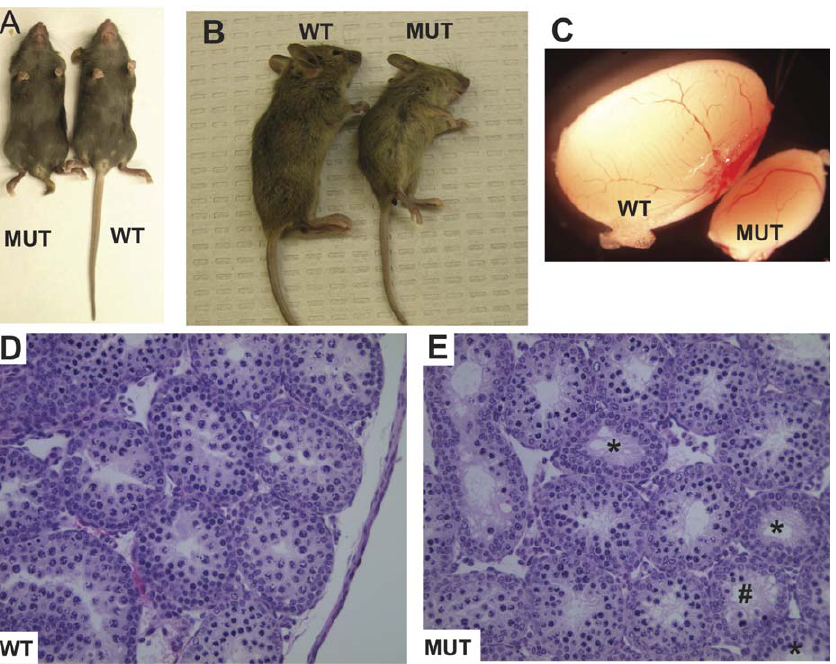
Figure 2. Developmental Phenotypes of Trip13 Mutant Mice (A) Shown are 21-d-old littermates. Note the shortened tail in the mutant, but overall similar body size. (B) Shown are 23-d-old littermates. The mutant is smaller in this case, but the tail is not as truncated as the mouse in (A). (C) Wild-type (WT) and homozygous Trip13 mutant (MUT) testes. (D) and (E) are cross sections through 17.5-d-old heterozygous ( ‘‘ WT ’’ ) and homozygous mutant Trip13 testes, respectively. Whereas the tubules in WT show coordinated spermatogenesis with pachytene spermatocytes present in all tubules (proximal to the lumen), developmental progression in the mutant is not synchronized between tubules. Some tubules have no pachytene spermatocyes (asterisks), while in others, development is somewhat disorganized (#).